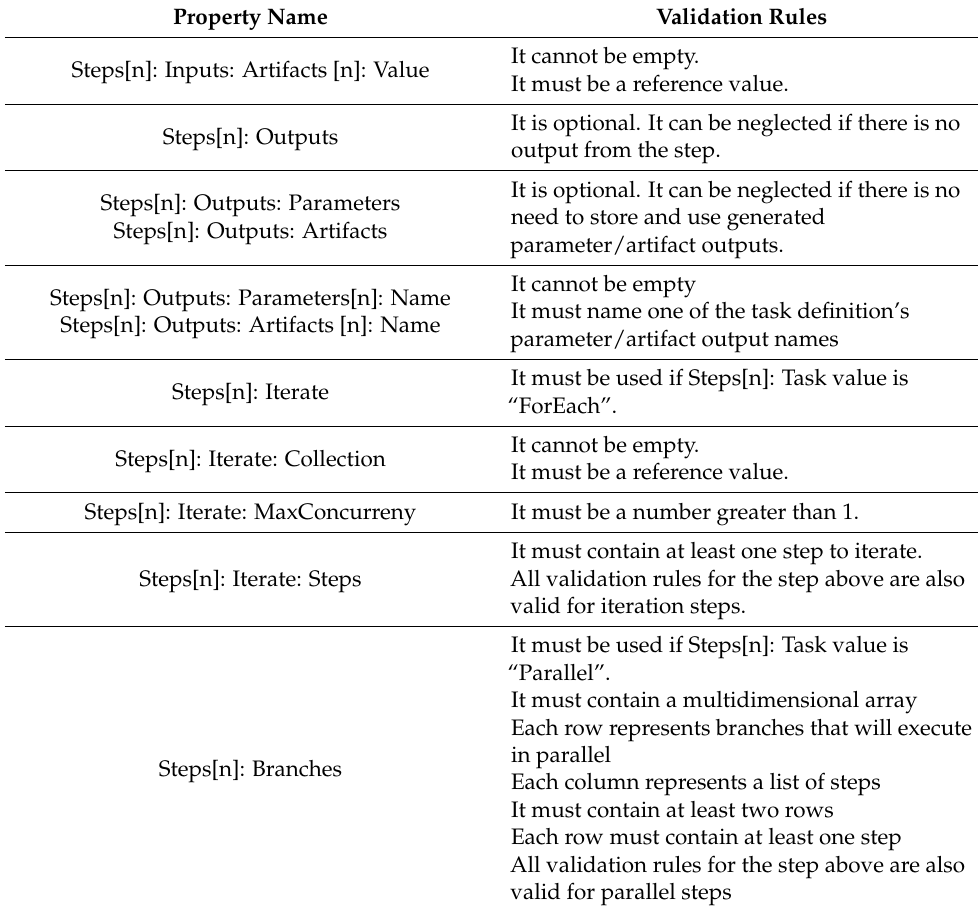
Table 2. Cont . Property Name Validation